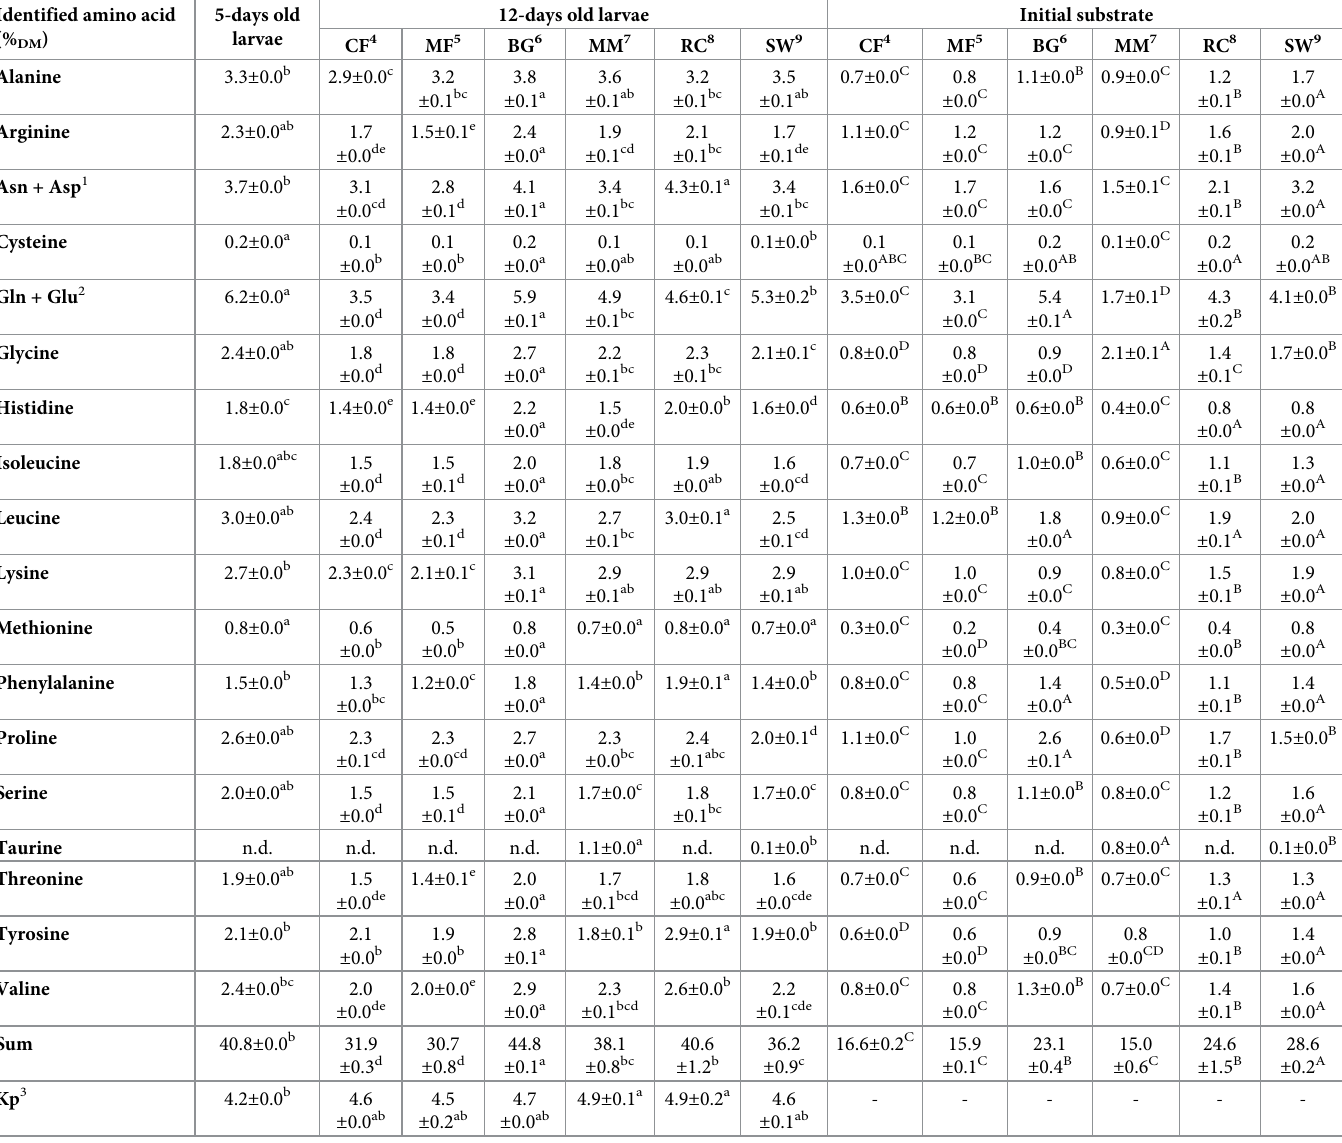
Table 4. Amino acid composition of black soldier fly larvae at the start (5-days old larvae) and the end (12-days old larvae) of the trial after feeding different rearing substrates for 7 days and the amino acid composition of initial substrates. All values are shown as mean ± standard error (SE; n = 3) in percentage of dry matter (% DM ), n.d. = not detected. Dissimilar lower case superscript letters represent significant differences between means within the same row for larvae data and capital super- script letters represent significant differences between means within the same row for initial substrate data (p < 0.05). Identified amino acid (% DM